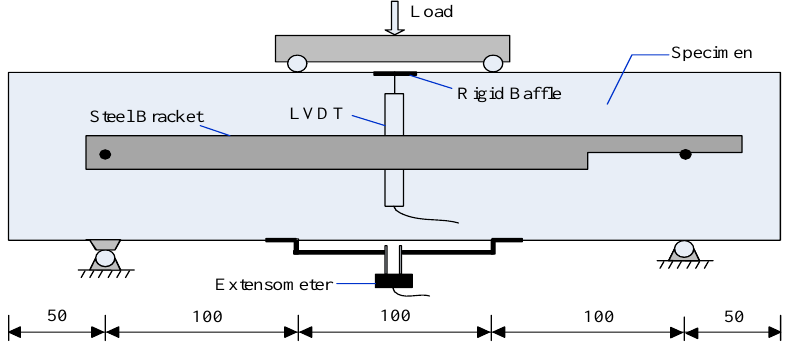
Figure 2. Schematic diagram for bending loading experimental set-up.